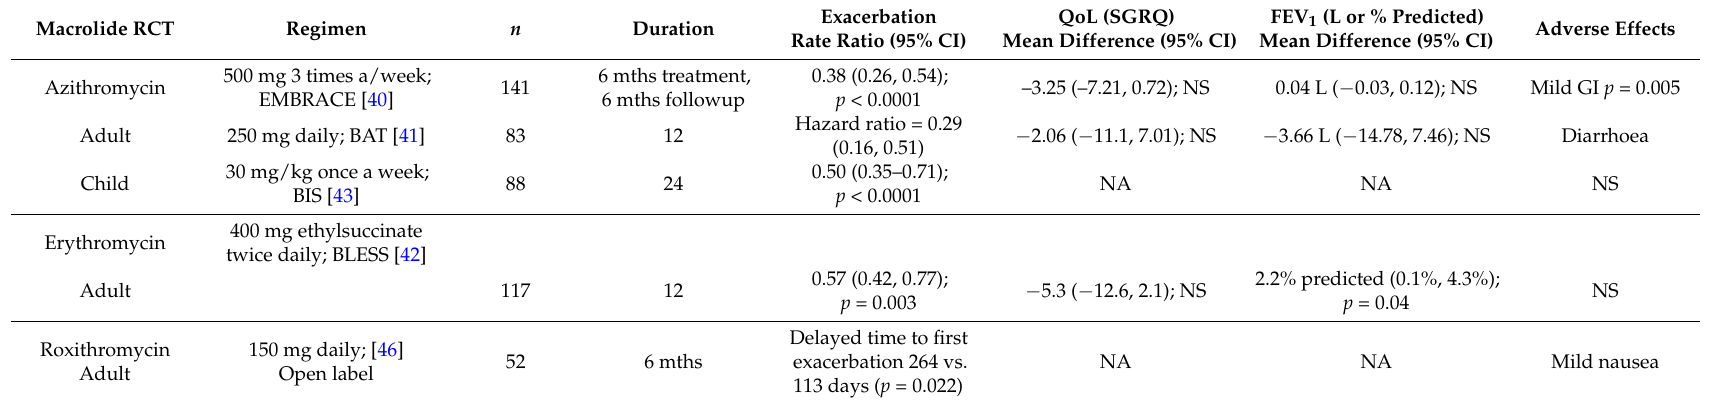
Table 2. Recent key macrolide RCTs in